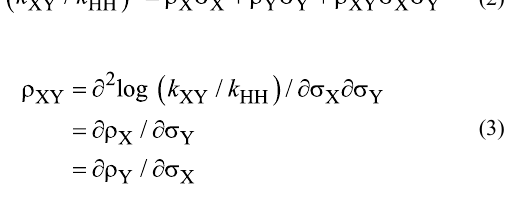
Figure 1: Brönsted plots with X [log k H versus p K a (X)] of the reactions of Y-aryl phenyl isothiocyanophosphates with XC 6 H 4 NH 2 in MeCN at 55.0